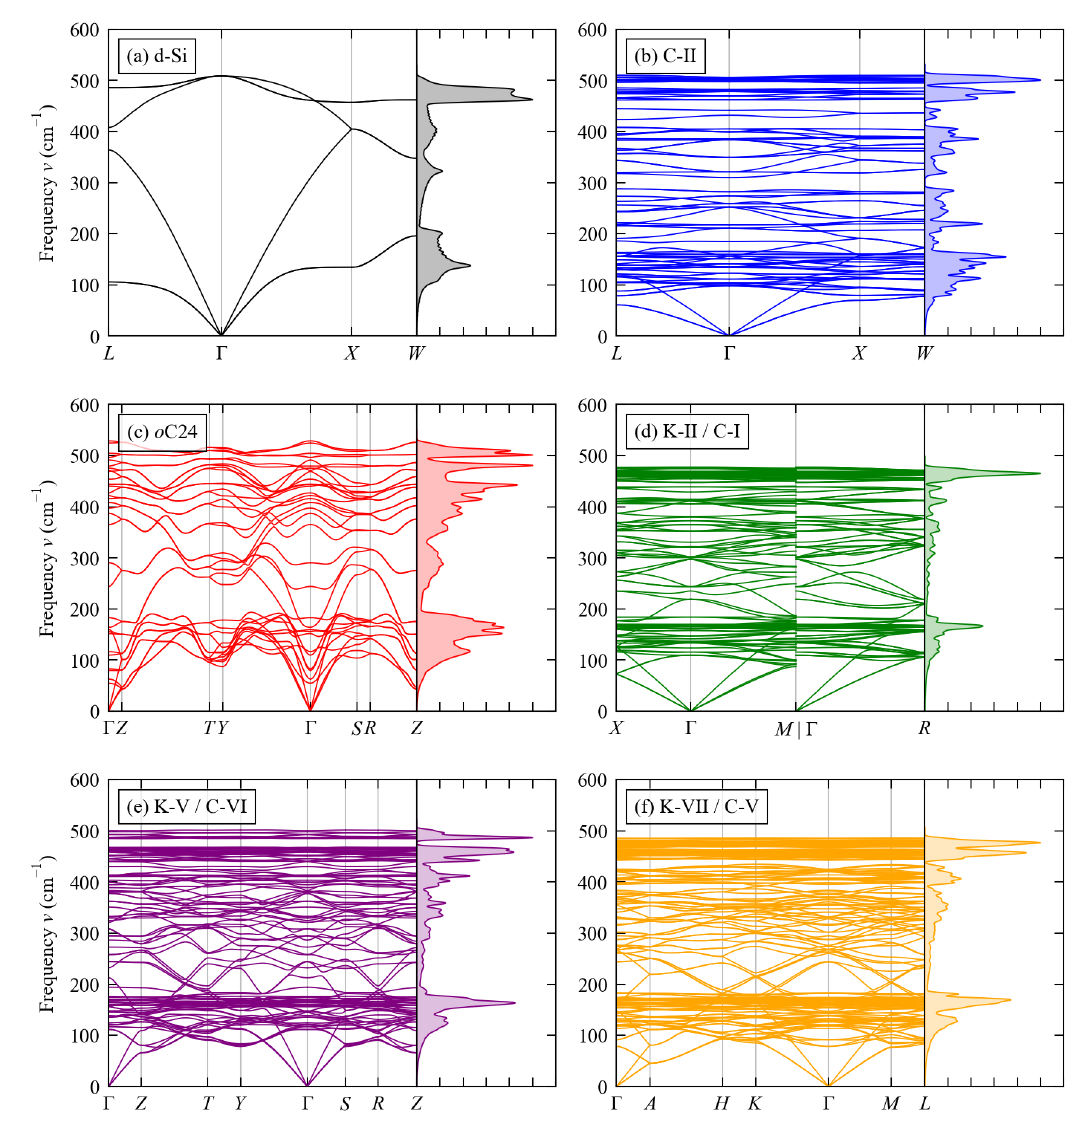
Figure 2. Calculated phonon dispersion ν ( q ) and density of states g ( ν ) curves of the six structures examined in this work: ( a ) d-Si, ( b ) C-II, ( c ) o C24, ( d ) K-II/C-I, ( e ) K-V/C-VI, and ( f )